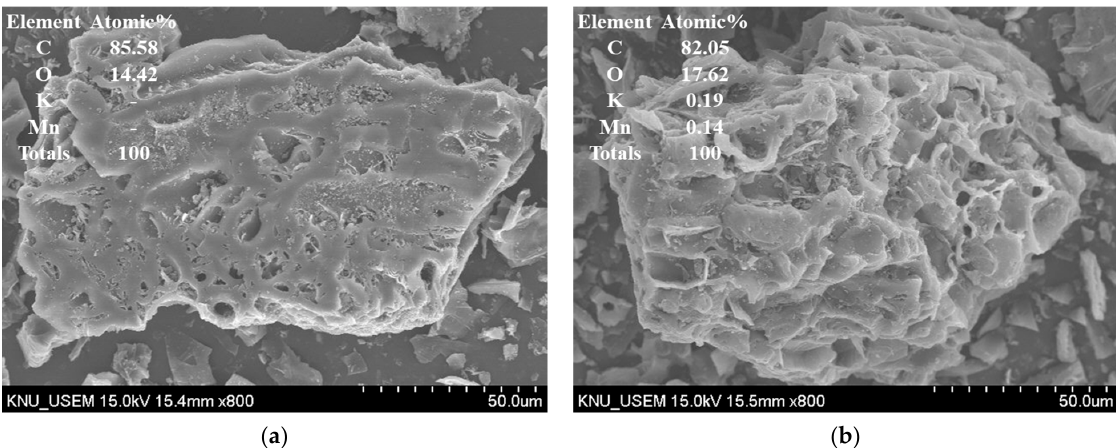
Figure 2. Scanning electron microscopy (SEM) images of ( a ) peanut shell biochar (PSB) and ( b ) KMnO 4 and KOH modified PSB (PSB OX-A ) (magnification ×800).